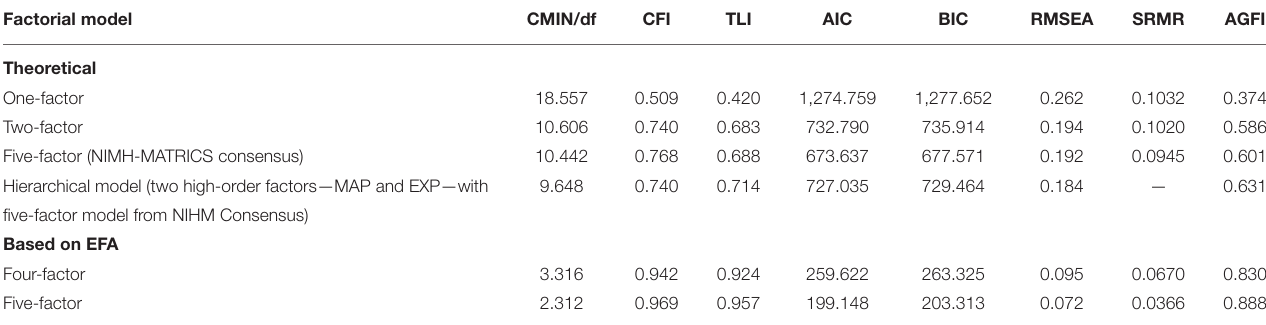
TABLE 3 | Goodness-of-fit indices of factorial models based on theories and on exploratory factor analysis (EFA) of negative symptoms. Factorial model